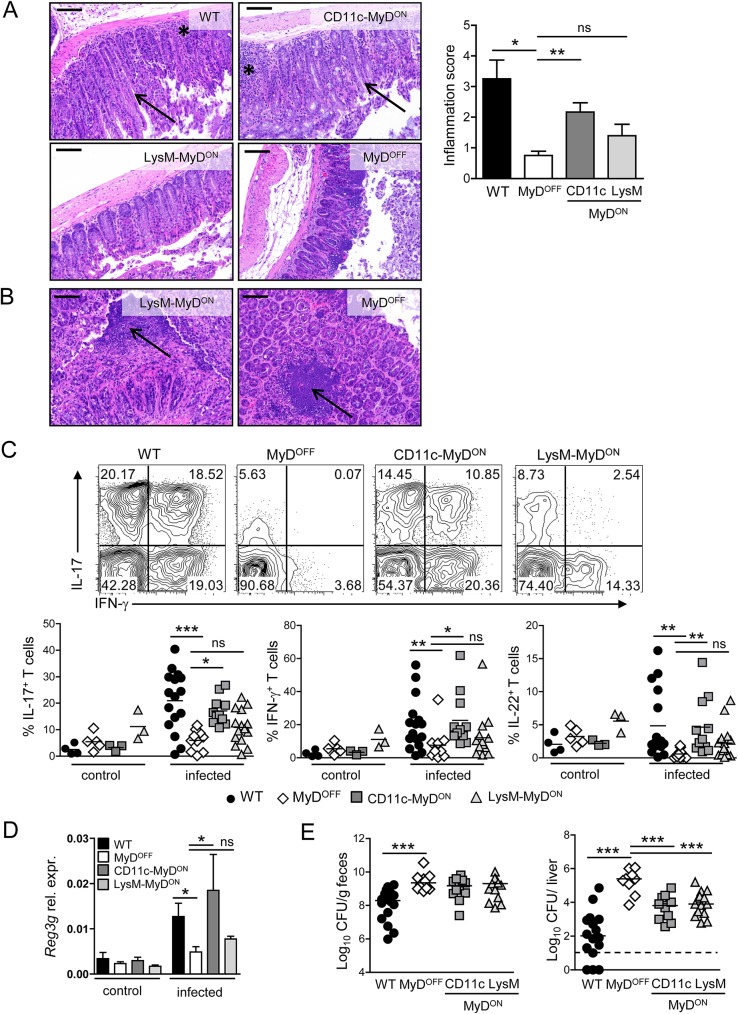
MyD88 signaling in CD11c+ cells is sufficient to induce an inflammatory response in the colon of mice infected with C. rodentium.(A, B) Representative H&E staining of colon sections of WT, MyDOFF, CD11c-MyDON and LysM-MyDON mice on day 8–10 p.i. with C. rodentium. Black asterisks indicate inflammatory infiltration into the cLP; black arrow heads indicate crypt elongation (A) or gangrenous-like necrotic structures (B). Scale bar represents 100 μm. Bar graph shows inflammation score based on infiltration and epithelial hyperplasia. (C) Leukocytes were isolated from the cLP of mice before (control) or on day 8 p.i. (infected) with C. rodentium and the T cell response was analyzed by flow cytometry. Representative flow cytometry plots of live CD3+CD4+ T cells stained for IL-17A and IFN-γ (upper panel). Graphs represent frequency (%) of IL-17A+ (IFN-γ+/−), IFN-γ+ (IL-17+/−) and IL-22+ cells amongst live CD3+CD4+ T cells (lower panel). (D) Expression of Reg3g in colonic epithelial cells isolated from mice before (control) or on day 8 p.i. (infected) with C. rodentium. Gene expression is shown relative to Actb. (E) Bacterial load in the feces and the liver on day 8–10 p.i. Data were pooled from two (A) or four (C, D) independent experiments with n = 3 mice (A) or n = 1–4 mice (C, D) per group. Horizontal bar represents mean. Error bar represents +SEM. Dashed line indicates the limit of detection. One-Way ANOVA with Bonferroni’s Multiple Comparison test; *p<0.05, **p<0.01, ***p<0.001, ns–not significant.